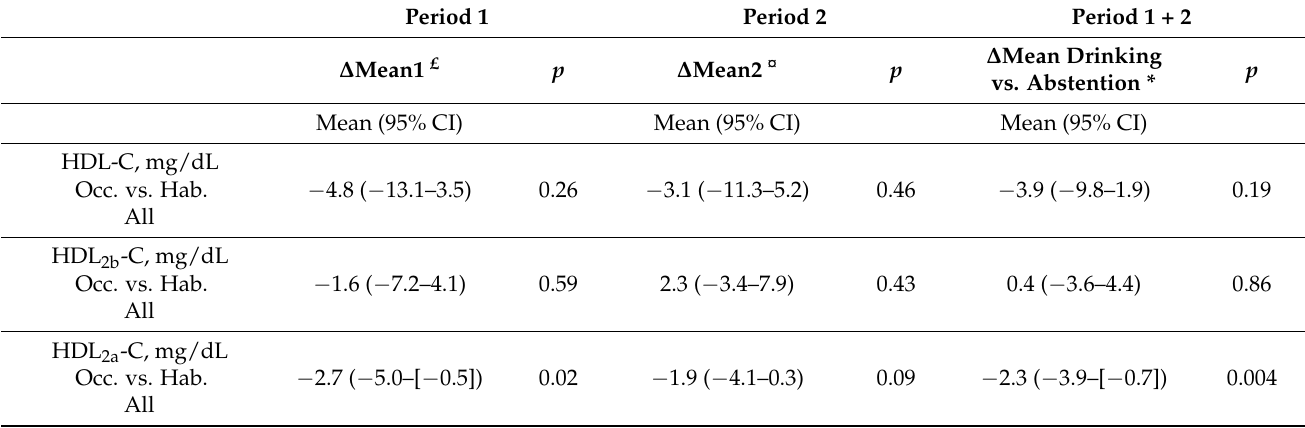
Table 3. Effects of 1–2 drinks (~12–24 g) per day on NMR measured HDLs, apoA1, and HDL subfrac- tions before and after alcohol intake or abstention and in drinking periods compared with